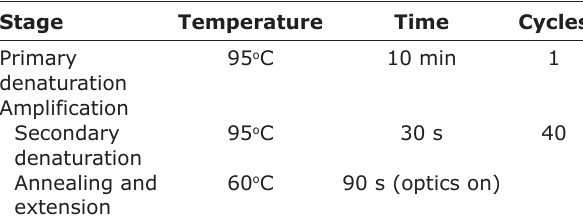
Table-3: RT-PCR cycling conditions. Stage